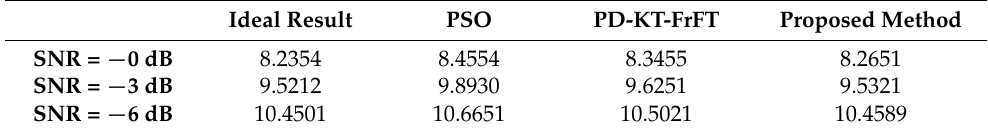
Table 1. The entropy of each imaging result.